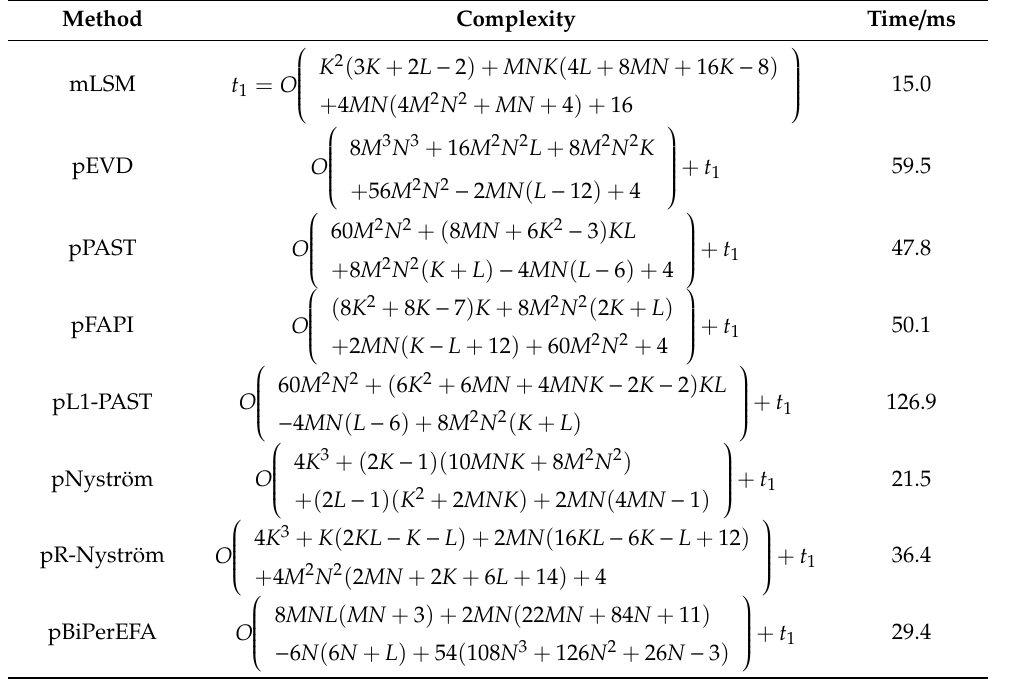
Table 2. Complexity and computation time